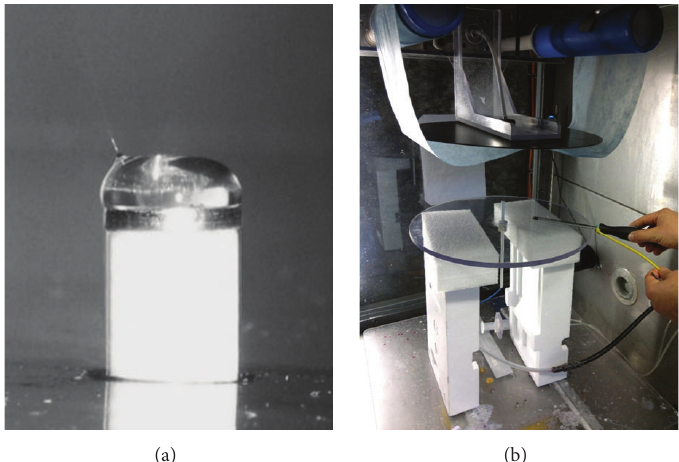
Figure 5: (a) Polymeric droplet with a jet under the critical potential and (b) removing of the remaining charge after the